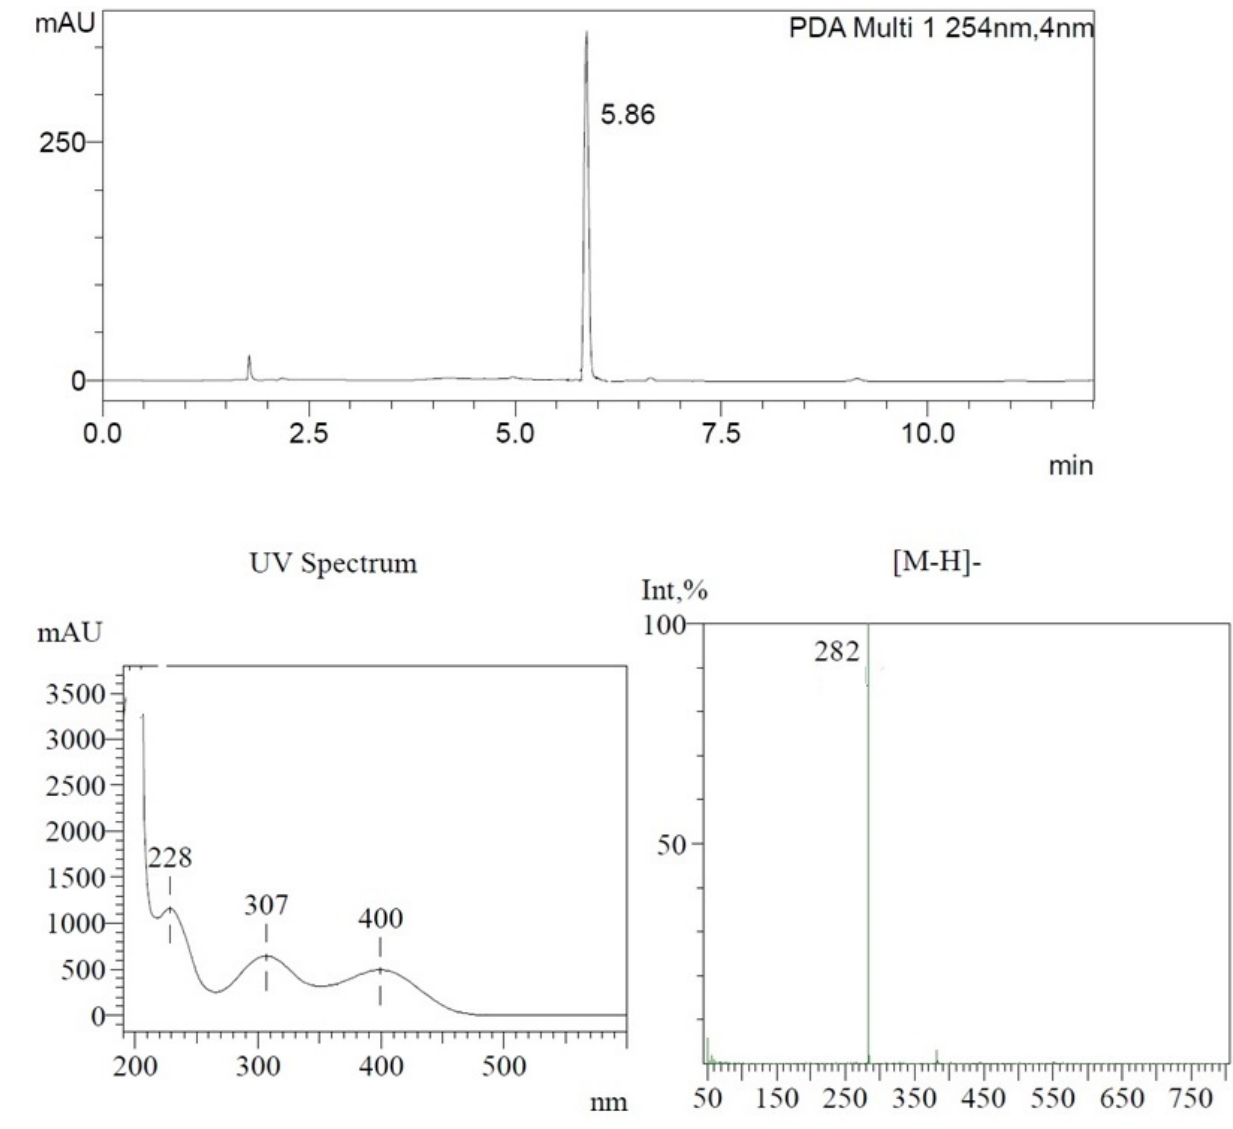
Figure 8. LC-MS analysis of 5-methyl-1,3-dihydro- 2H -benzimidazol-2-one nitration product (2 mg/1 mL DMSO), 5-methyl-4,6,7-trinitro-1,3-dihydro- 2H -benzimidazol-2-one (5-Me-TriNBO, ( 2 )). UV spectrum λ max = 228, 307, 400 nm; R.T.= 5.86 min., molecular ion: [M-H] − =282 in negative mode.